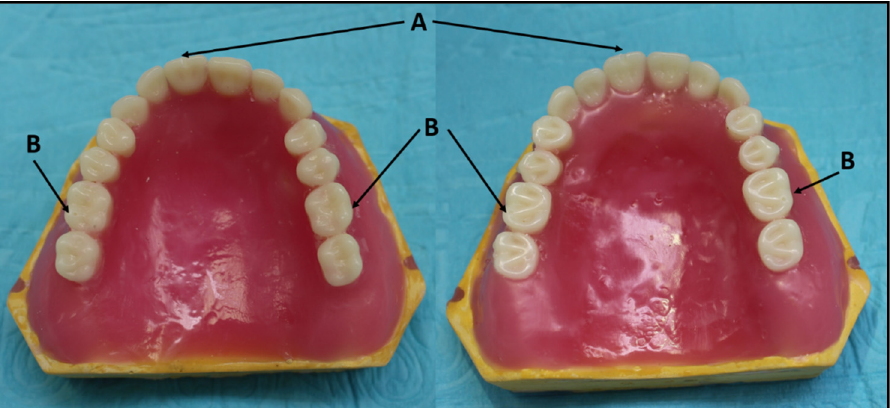
Figure 2. Dentures before processing: ( A ) vertical groove placed on the right central incisor incisal edge; ( B ) round holes on the disto-buccal cusps or right and left first molars.